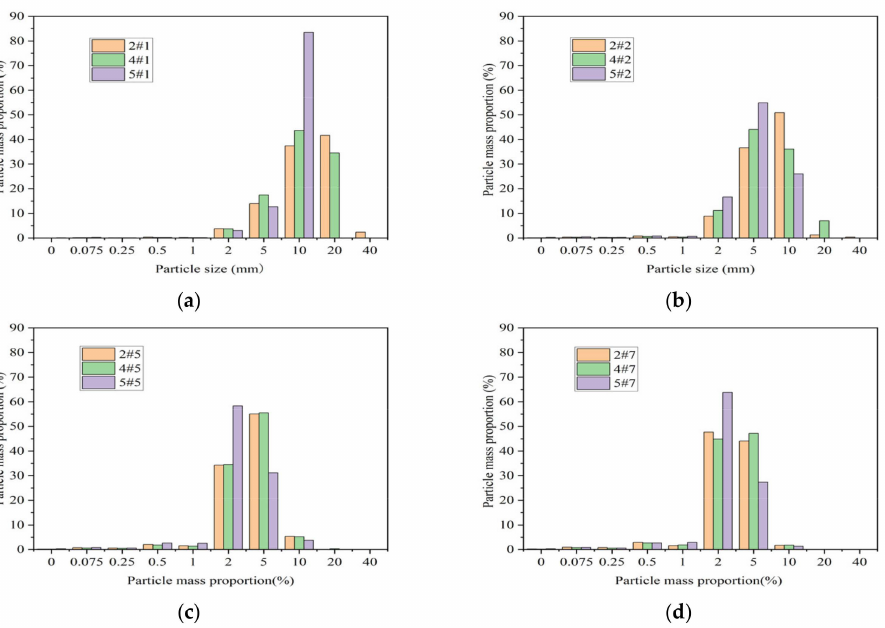
Figure 15. Comparison of disintegrating particle content with different initial sizes: ( a ) the 1st cycle; ( b ) the 2nd cycle; ( c ) the 5th cycle; ( d ) the 7th